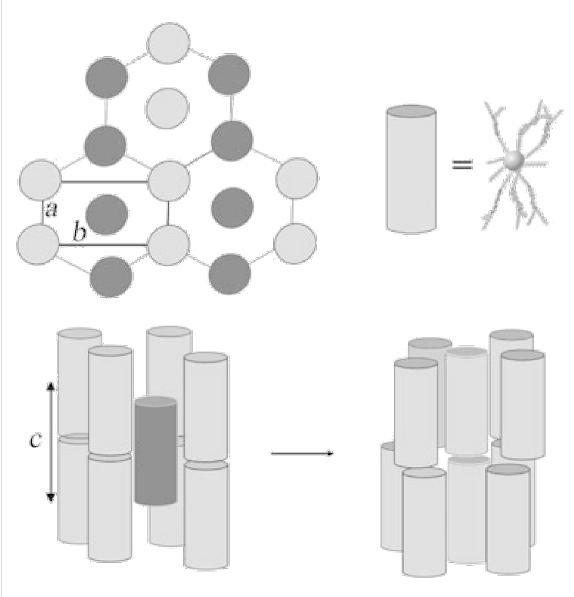
Figure 9: Schematic drawing of the arrangement of nanoparticles in the columnar phase, as viewed from above (top left) and from the side (bottom). The rearrangement of the ligands about the gold NP to form a cylinder is shown (top right). The smectic structure for Au@C 10 /7 9,9 (bottom right) can be obtained from the columnar phase for Au@C 10 / 7 4,4 and Au@C 10 /7 1,6 (bottom left) through movement of the particles from the intermediate layer along the column axis and decoupling of the layers. Reprinted with permission from [63]. Copyright 2009 Wiley- VCH Publishers.